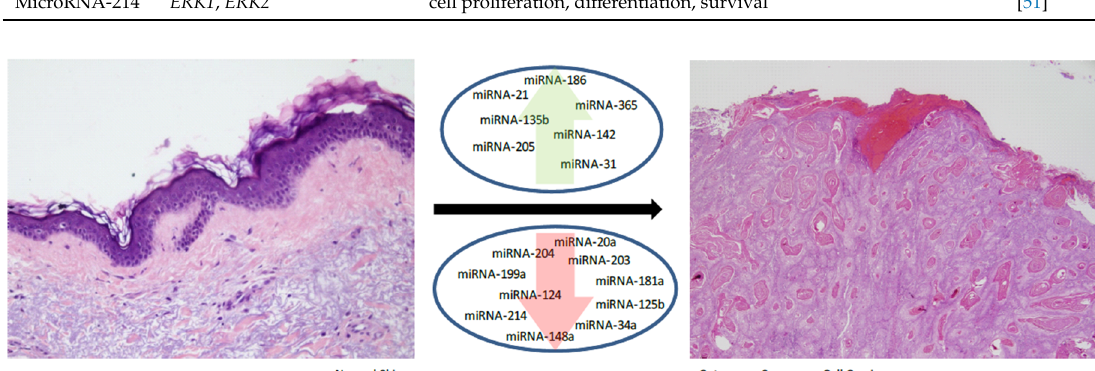
Figure 2. MiRNA dysregulation in cutaneous squamous cell carcinoma compared to normal skin.